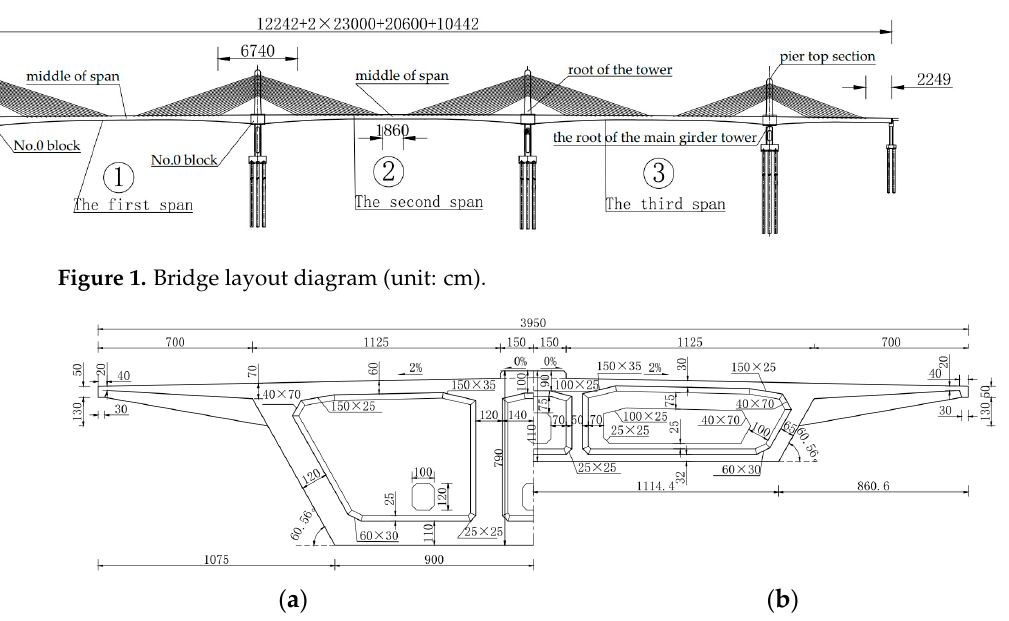
Figure 2. Cross-sectional con fi guration of main girder (unit: cm). ( a ) Pier top section. ( b ) Mid-span section.